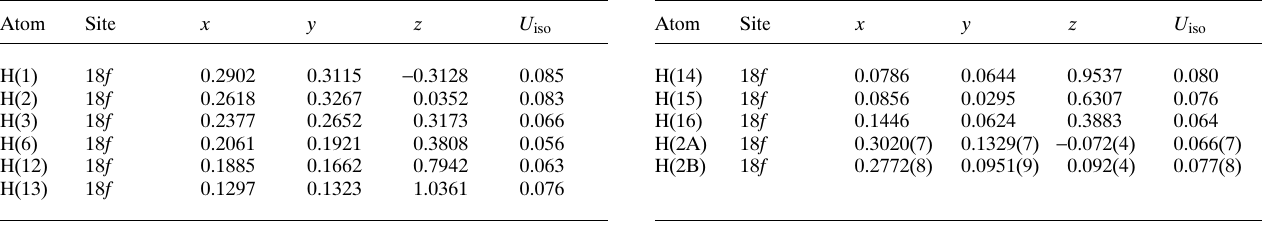
Table 2. Atomic coordinates and displacement parameters (in Å 2 )